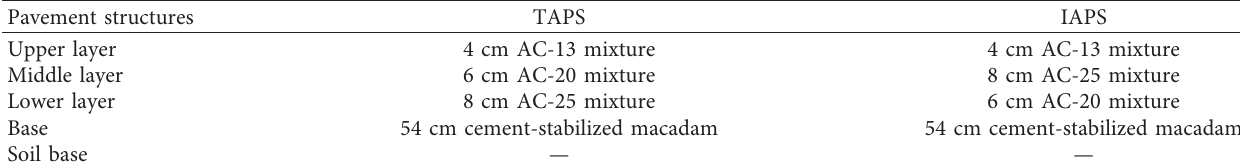
Table 1: Layer structure of the TAPS and IAPS.